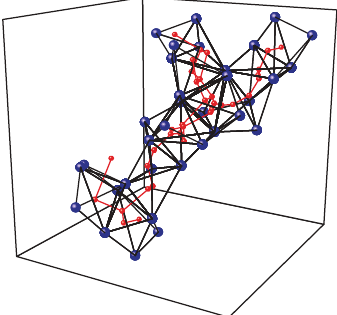
Figure 1: The dense-part cluster in MD model of water at 300 K and its frame (broken red line); blue points are the molecules and red points are centers of the cluster